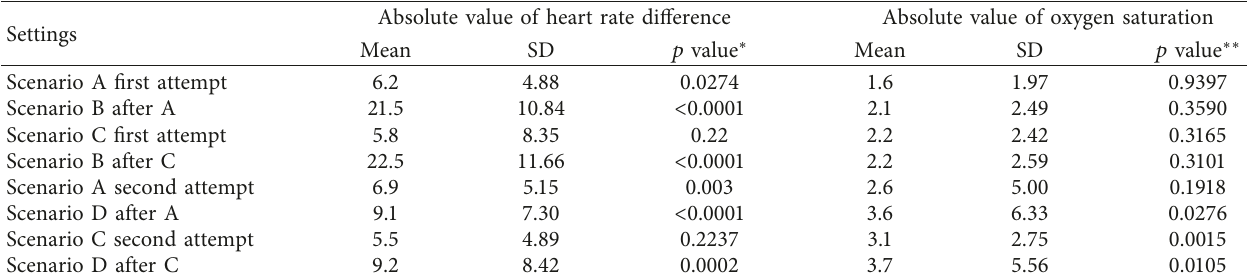
Table 2: Estimation accuracy of heart rate and oxygen saturation under different recording